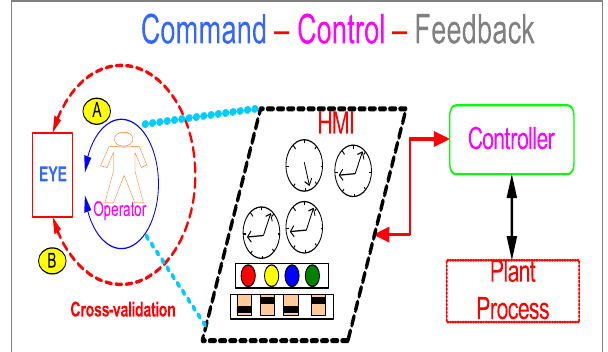
Figure 1. Command-Control-Feedback architecture is ubiquitous to most industrial and transportation operations. ( A ) The operator in the control loop visually acquires most plant process information via Human Machine Interface (HMI) states, perform required command actions and receive feedback via the displayed HMI